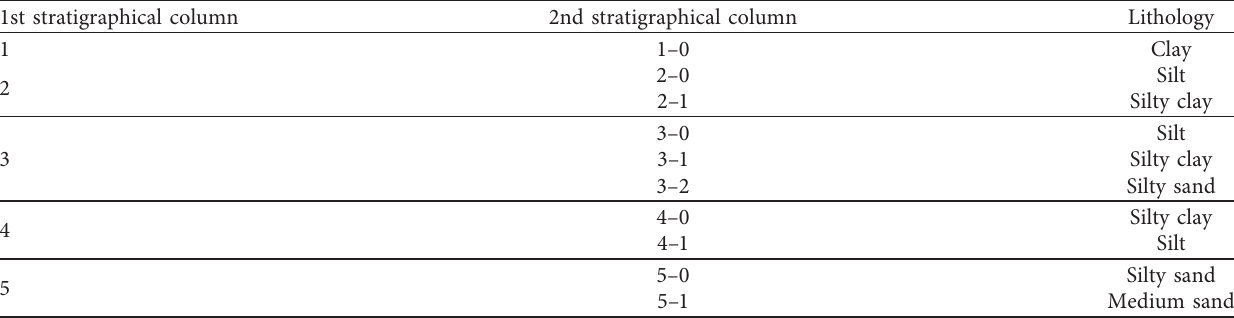
Table 2: The layer code of strata and its coarsen results in site scale.